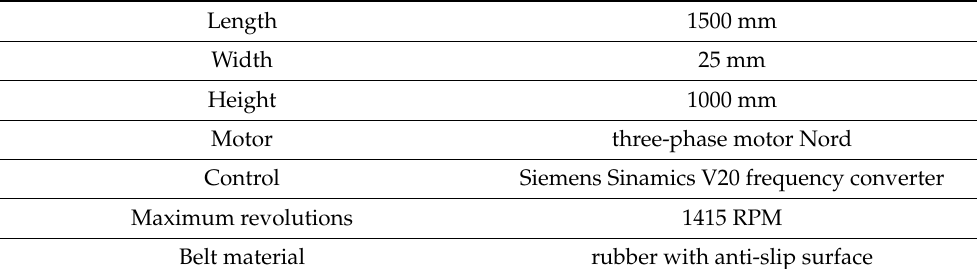
Table 2. Automatica conveyor belt specifications.